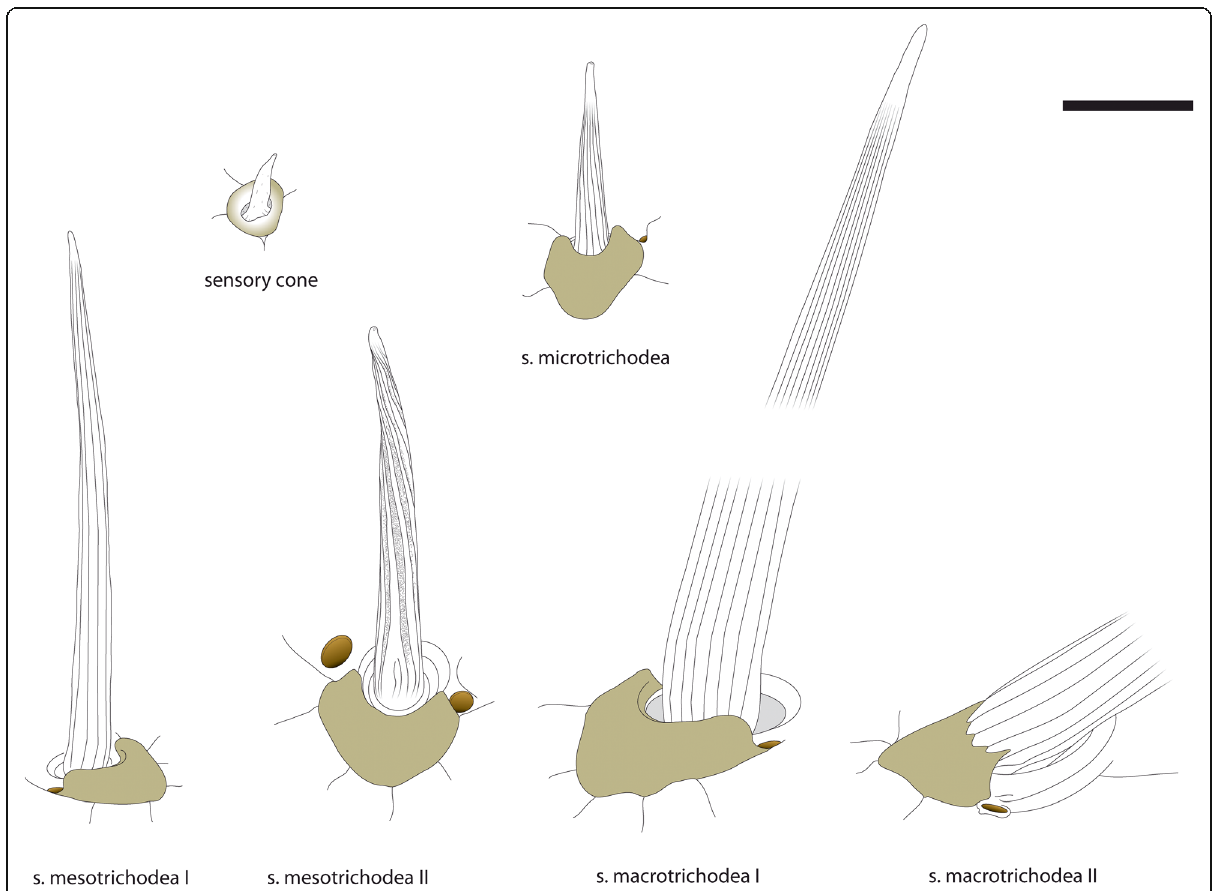
Fig. 5 Compilation of schematic drawings of sensilla types found on walking leg 10 and ultimate leg. Scale bar 10 μ